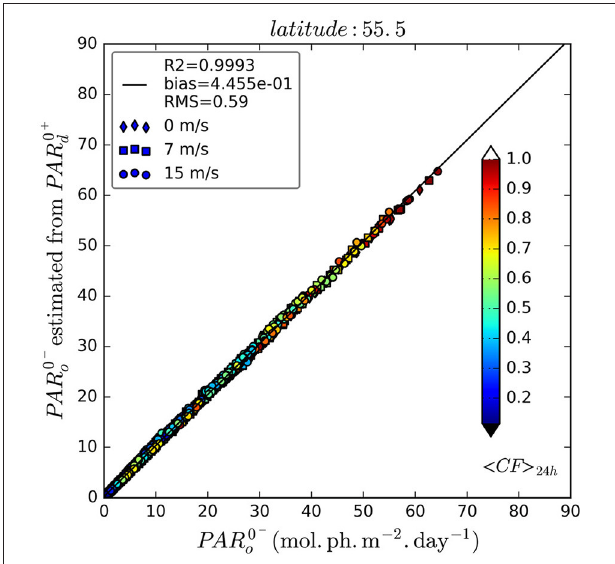
FIGURE 12 | Estimated scalar PAR below the surface from the planar PAR above surface and the clear sky “transmission factors” shown in Figure 11 for all the days of 2011 and 3 wind speeds. The color of the symbols is a function of the cloud factor.